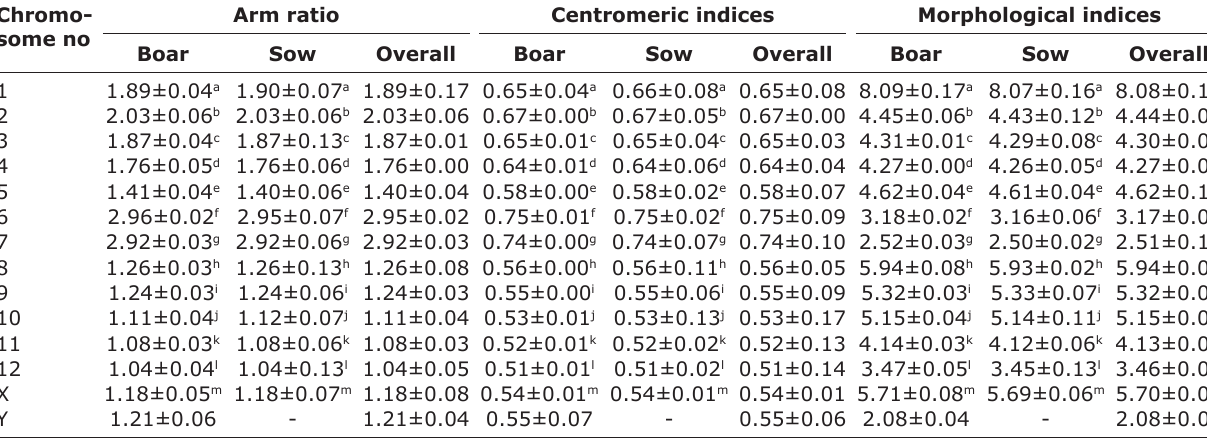
Table-1: Morphometric measurements of chromosomes (mean±SE) in indigenous pigs. Chromo- Arm ratio Centromeric some no